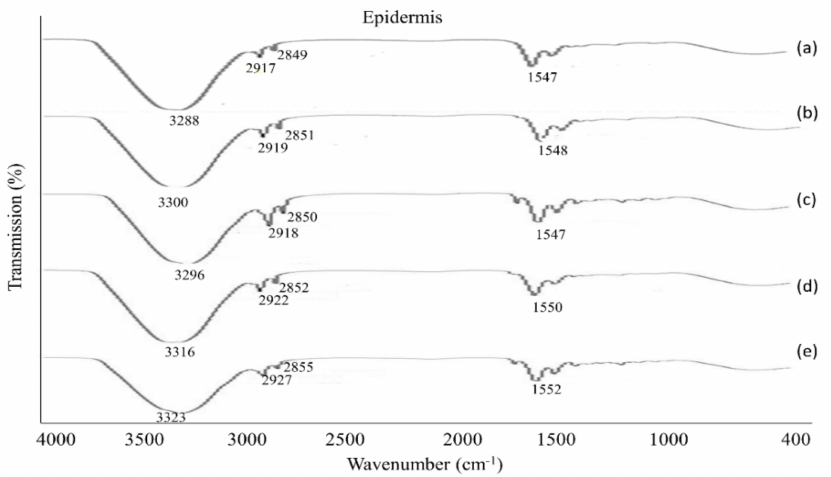
Figure 6. ATR-FTIR spectra of the epidermis ( a ) untreated skin, and skin treated with ( b ) F1, ( c ) F2, ( d ) F3 and ( e ) F4., data are express as mean ± S.D, n =